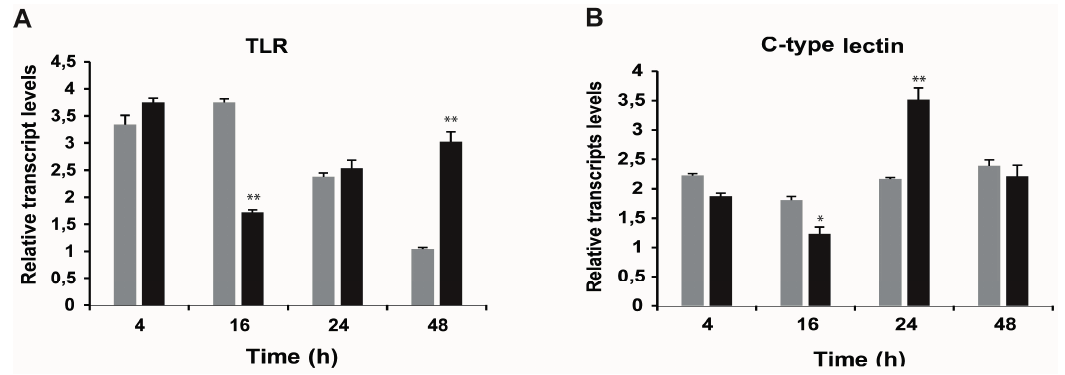
Figure 5. Relative transcript levels for studied genes (TLR ( A ) and C-type lectin ( B )) of the pattern recognition receptor (PRR) in cultured hemocytes after exposure to STX. Cells were seeded in six-well plates, and after three days of culturing, cells were incubated with 100 nM STX for 4, 16, 24 or 48 h. Black bars = Challenged hemocytes (STX exposed); grey bars = Control hemocytes (mean ± SE, n = 4 cultures of hemocytes). * p < 0.05 and ** p < 0.01 represent statistical differences at 4, 16, 24 and 48 h after incubation with STX as compared to the control group (ANOVA/Tukey